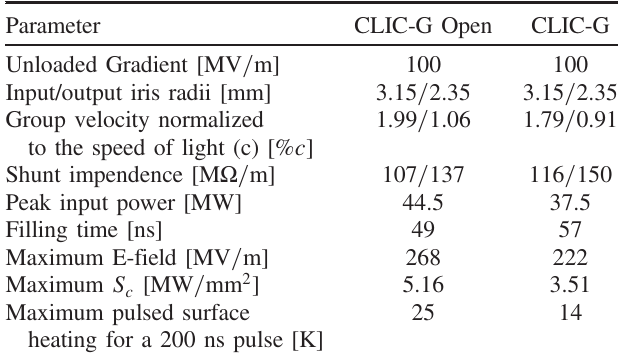
TABLE I. Structure parameters for the CLIC-G-Open structure compared to the CLIC-G structure [11]. All values are normalised to an unloaded gradient of 100 MV =